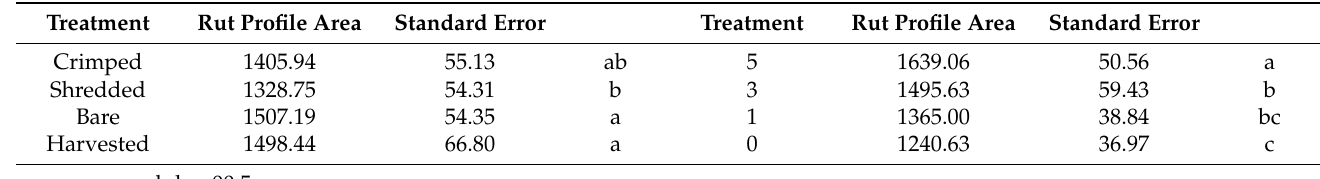
Table 3. Result of statistical analysis on Rut area profiles (cm 2